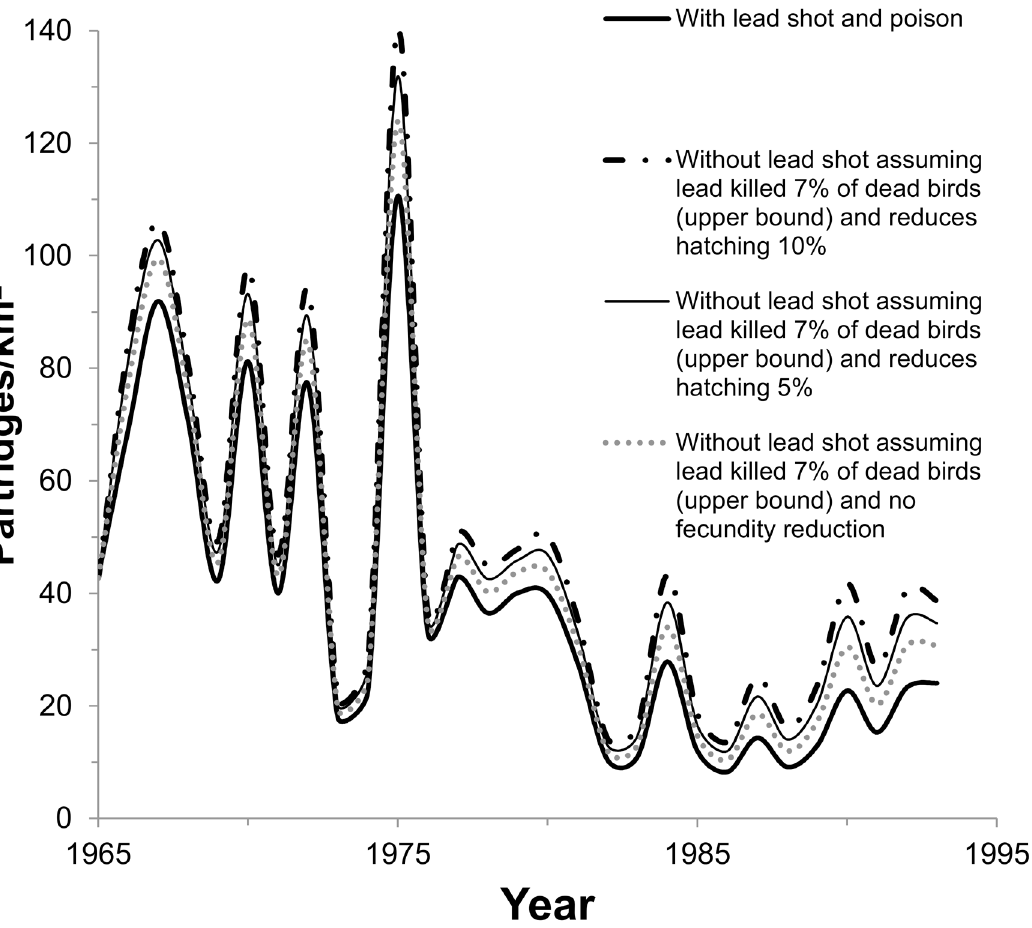
Fig 7. Results of sensitivity analysis, assuming lead shot ingestion additionally reduces fecundity for partridge scenarios in Fig 4b by 5 or 10%. Only the upper-bound estimate is compared to baseline, representing removal of ingestion of lead shot that caused 7% of the